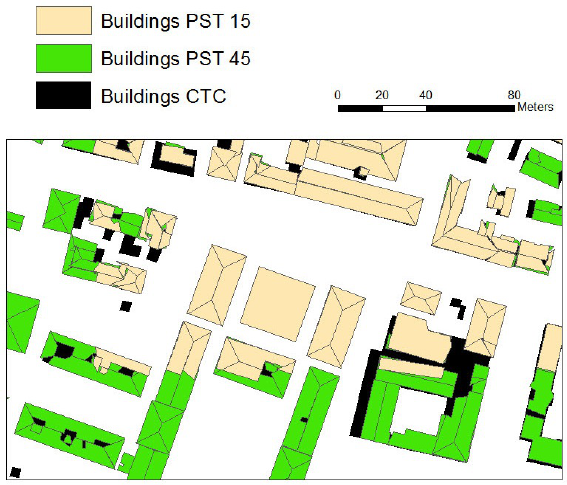
Figure 3: Results from different Plane Surface Tolerance values